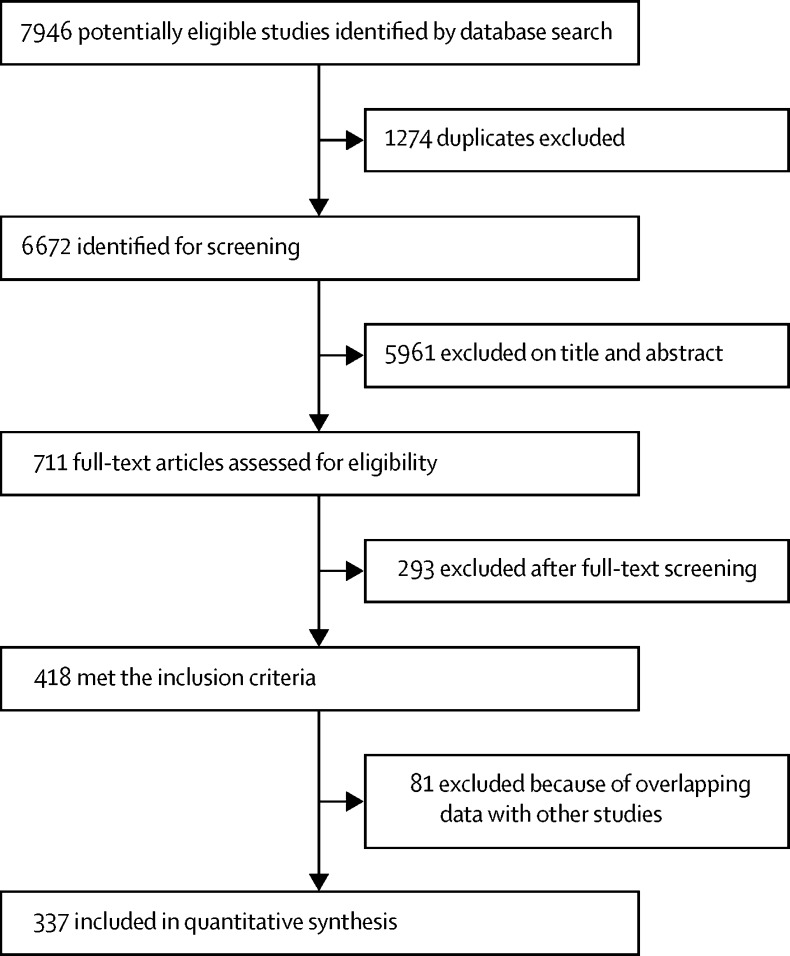
Study selection